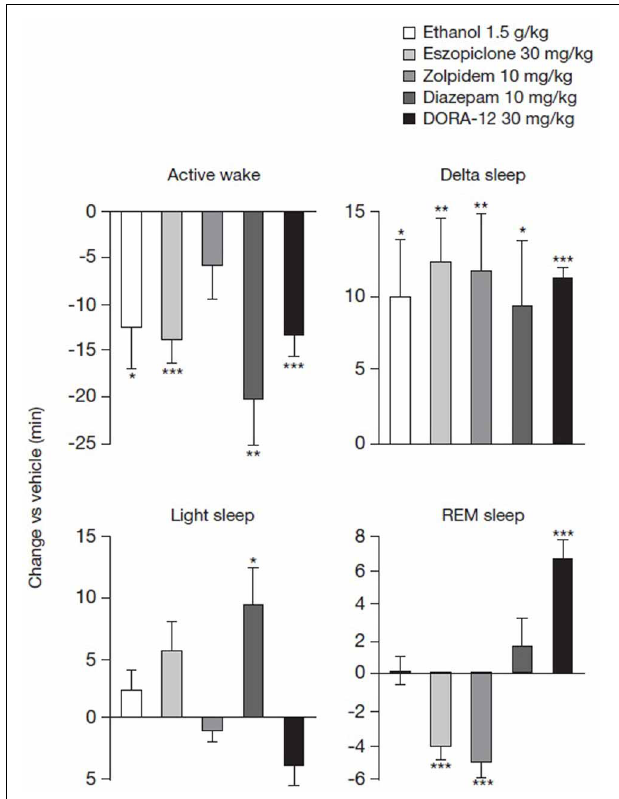
FIGURE 3 | Differential effects of ethanol, GABA-A receptor modulators and DORA-12 on sleep stages. Mean time in active wake, delta, light and REM sleep was monitored for 2h after PO administration of ethanol (1.5 g/kg), eszopiclone (30mg/kg), zolpidem (10mg/kg), diazepam (10mg/kg), or DORA-12 (30mg/kg). Three consecutive days of each treatment was administered in a balanced cross-over design such that each subject received drug and vehicle. Mean within-subject change relative to vehicle is shown. Data were analyzed using within-subject paired t -tests relative to vehicle ( N = 8–16; ∗ p < 0 . 05, ∗∗ p < 0 . 01, ∗∗∗ p < 0 . 001). PO, paraoral; REM, rapid eye